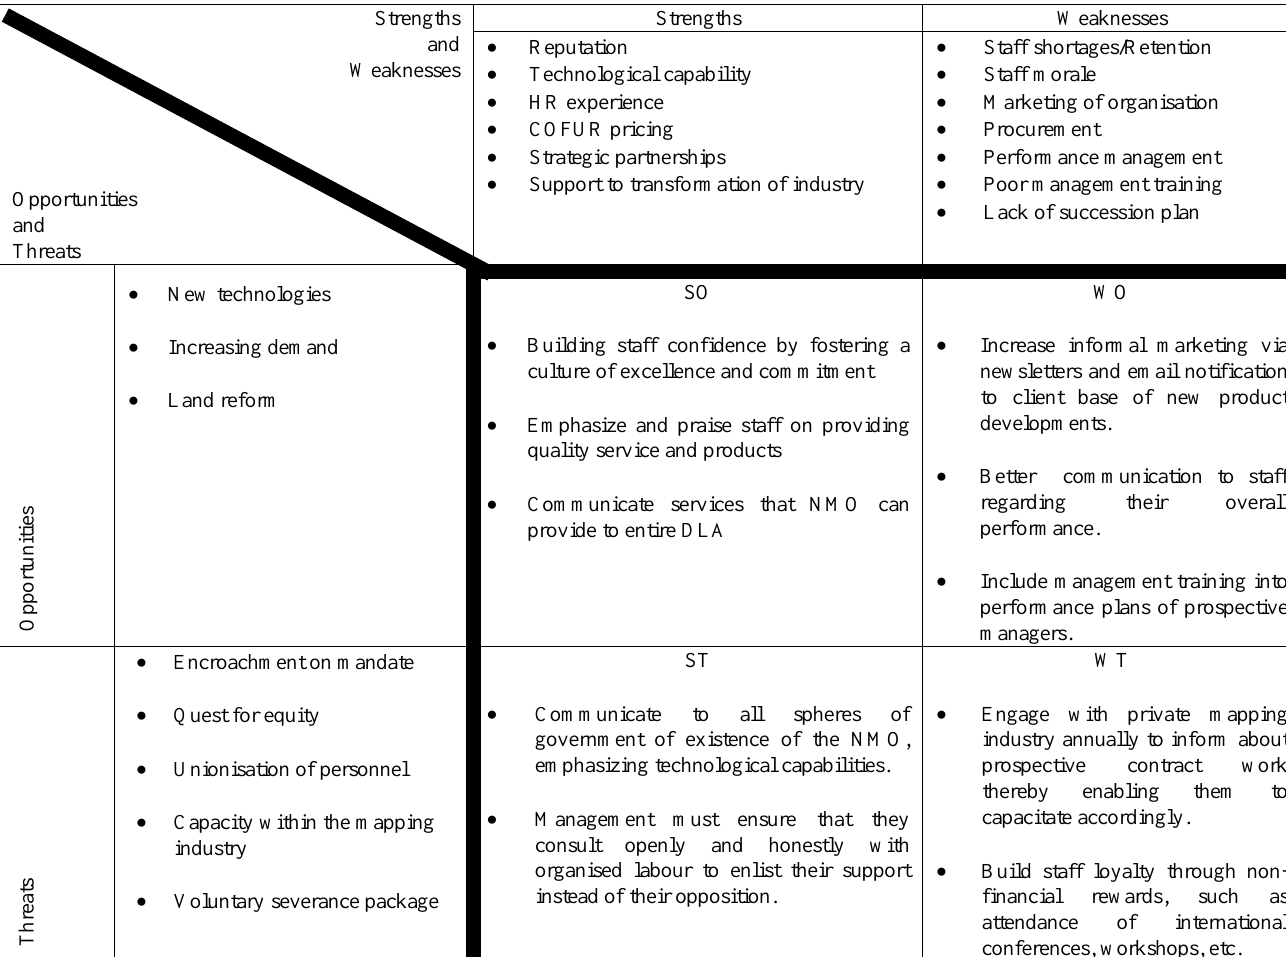
Table 2: A SWOT matrix for the NMO